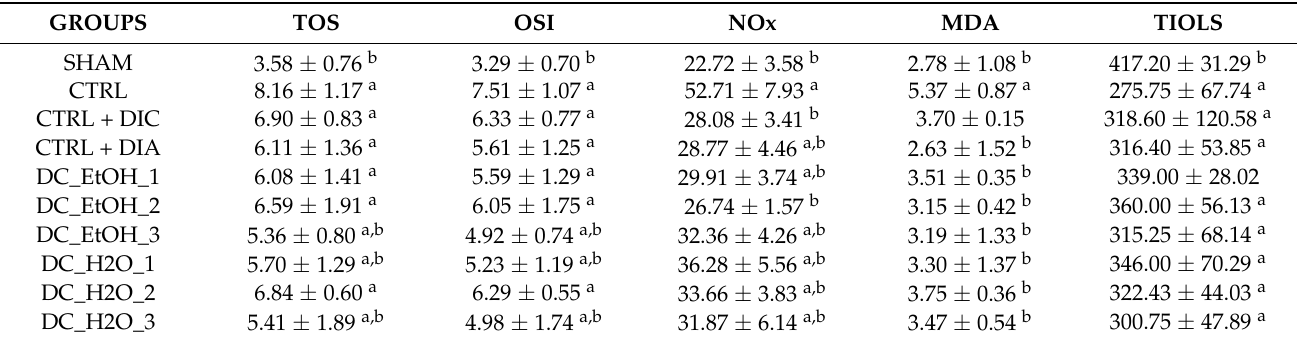
Table 4. Effect of Dichrostachys cinerea fruit extracts on oxidative stress parameters serum levels in CFA-induced arthritic